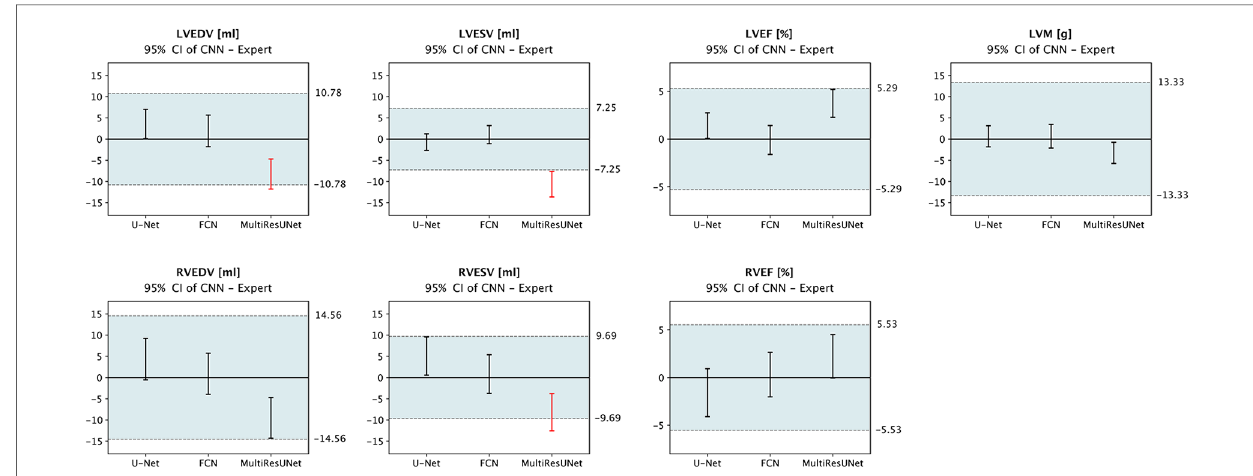
FIGURE 6 Equivalence testing for clinical parameters. The 95% con fi dence intervals of mean errors in quantitative clinical parameters are plotted against the tolerance intervals (blue) as de fi ned by Zange et al. (30) and Gröschel et al. (17) based on intraobserver variability. Equivalence is assumed if the respective CI lies completely within the tolerance range. Legend: CI, con fi dence interval; LVEDV, left ventricular end-diastolic volume; LVESV, left ventricular end-systolic volume; LVEF, left ventricular ejection fraction; LVM, left ventricular myocardial mass; RVEDV, right ventricular end-diastolic volume; RVESV, right ventricular end-systolic volume; RVEF, right ventricular ejection fraction; red, outside tolerance